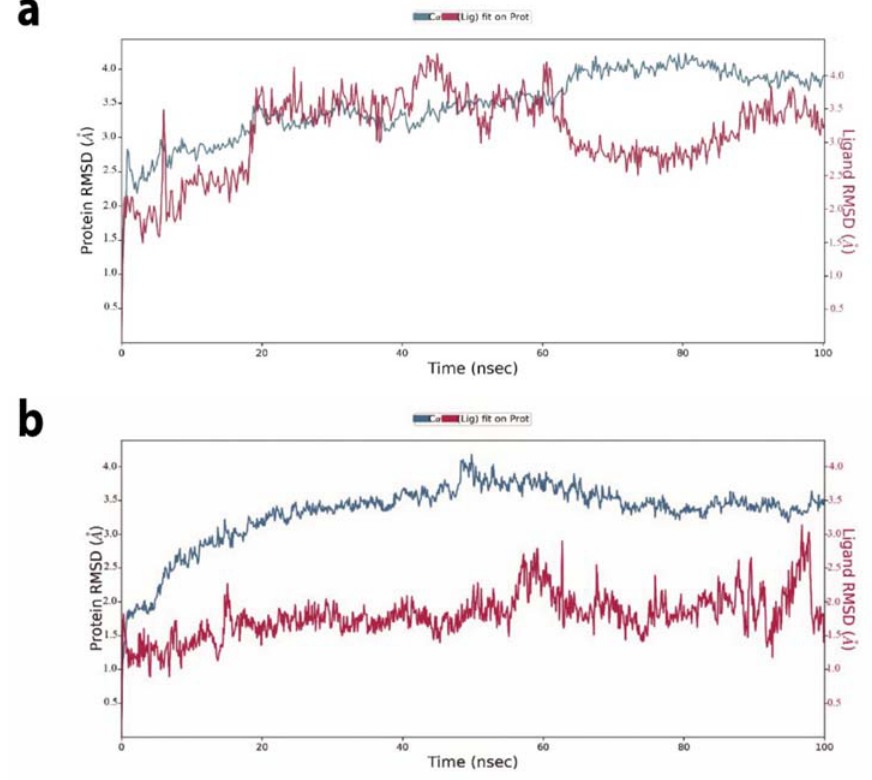
Figure 10. The RMSD plot of docked complexes during 100 ns MD simulation. ( a ) querce ‐ tin ‐ 7 ‐ O ‐ [ α‐ L ‐ rhamnopyranosyl(1 → 6) ‐β‐ D ‐ galactopyranoside] and ( b ) luteolin 7 ‐ O ‐